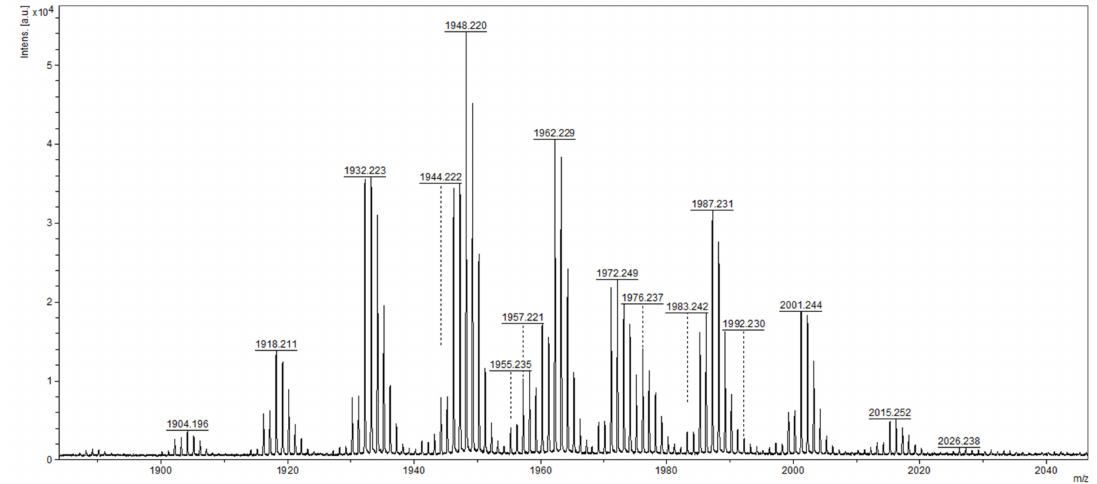
Figure 1. MALDI-TOF mass spectrum profile of crude extract of peptaibols on the 12th day of cultivation in light–dark conditions. The m/z values correspond to the atroviridins group of peptaibols, as described by Komon-Zelazowska et al., (2007)